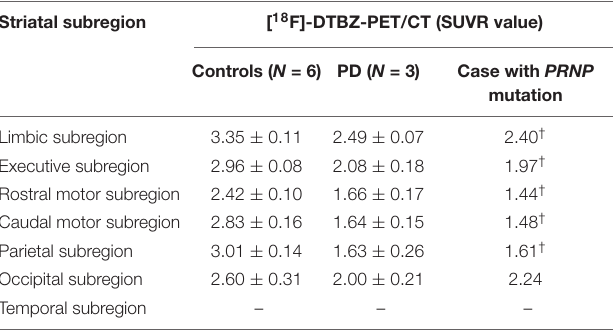
TABLE 2 | Comparison of the striatal functional distribution in this case and controls/cases with PD using [ 18